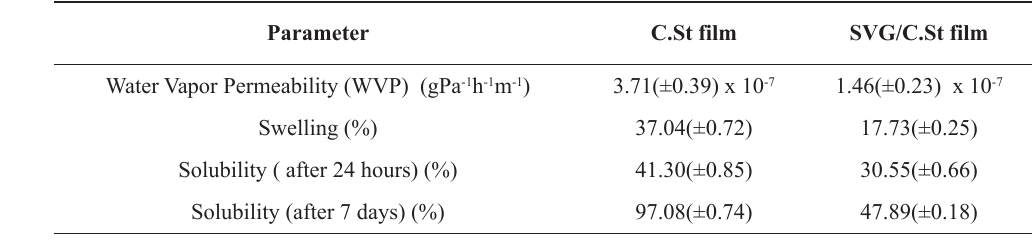
Table 1: Water vapor permeability, Swelling, and Solubility of the film obatained from cassava starch (C.St film) and polymer composite film from cassava starch and SVG (SVG/C.St